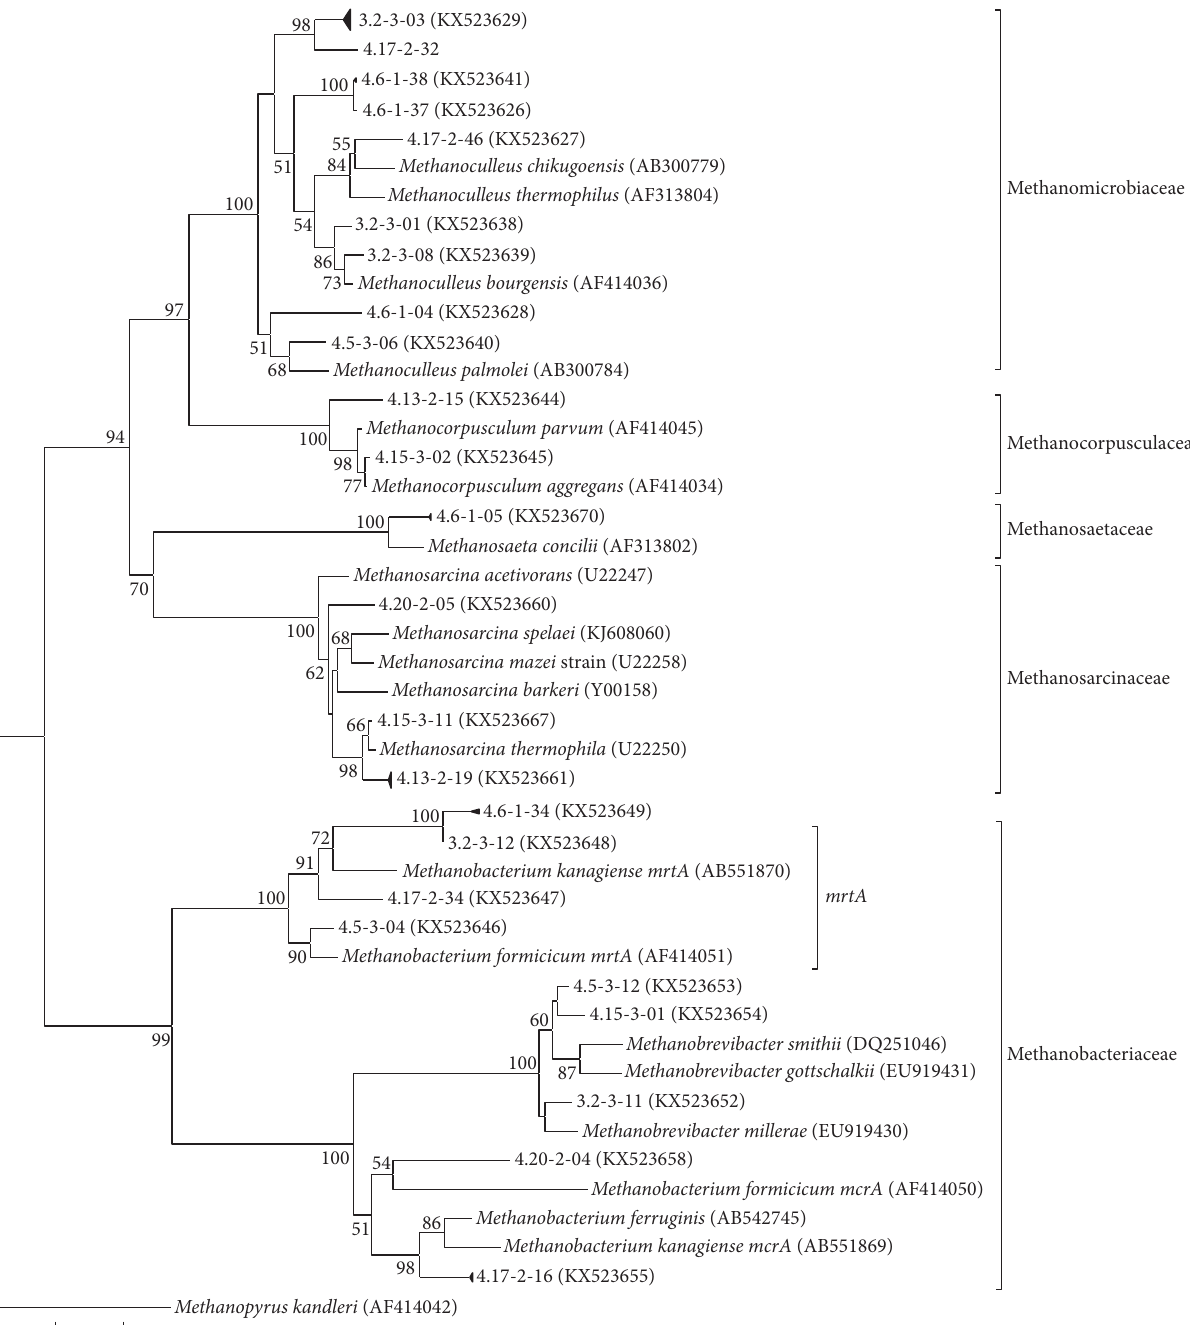
Figure 1: Phylogenetic tree indicating the relationship of selected mcrA and mrtA gene sequences to those retrieved from methanogenic strains. Analysis was conducted in MEGA5 using the neighbor-joining method based on Jukes-Cantor evolutionary distances. The percentages of replicate trees in which the associated taxa clustered together in the bootstrap test (1000 replicates) are shown next to the branches. Branches containing more closely related clone sequences were compressed and only one selected clone is shown. Accession numbers of the sequences are shown in brackets. Methanopyrus kandleri was used as outgroup reference. The scale bar represents 5% sequence